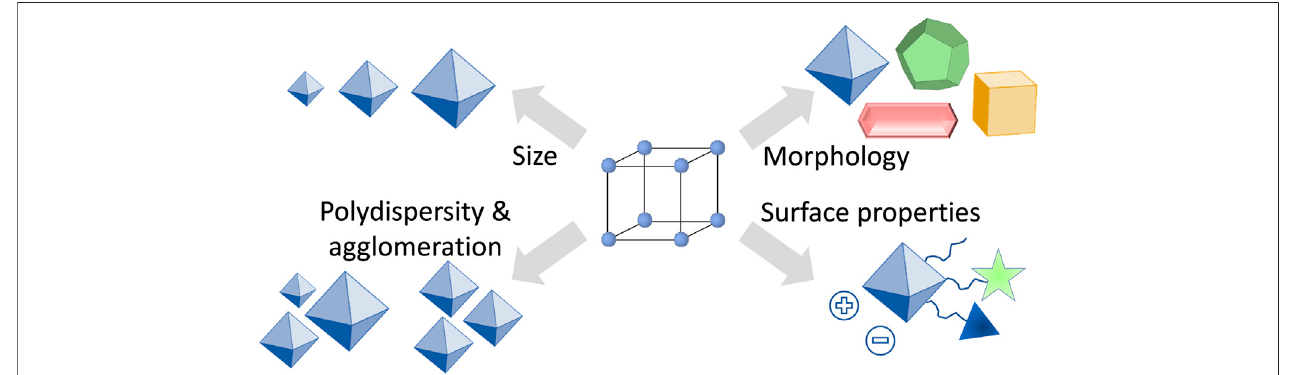
FIGURE 2 | Overview of important characteristics of MOF nanoparticles for applications in drug